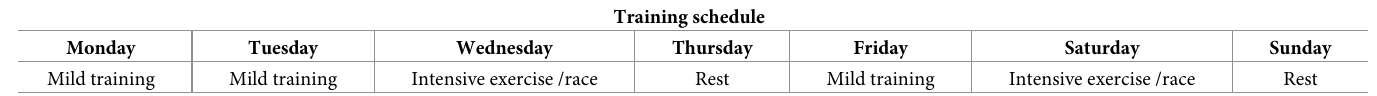
Table 1. Weekly training schedule of the experimented